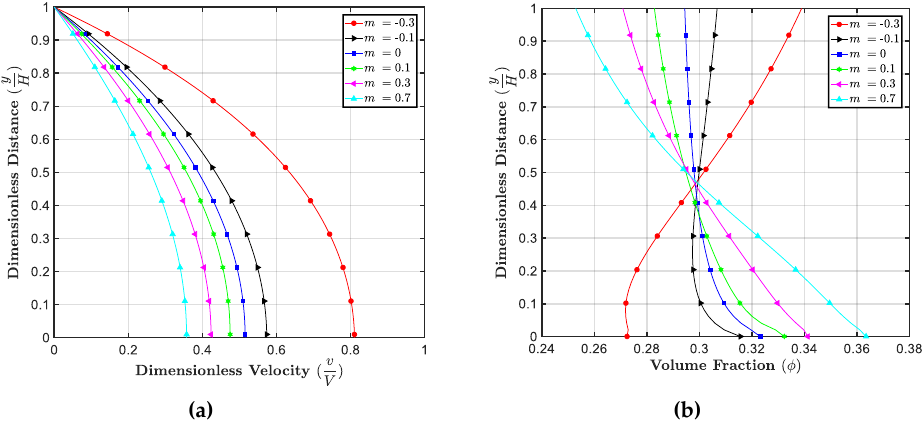
Figure 9. Effect of m on ( a ) the velocity; and ( b ) the volume fraction profiles, with 𝛽 = 1.82, 𝜙 𝑎𝑣𝑔 = Figure 9. E ff ect of m on ( a ) the velocity; and ( b ) the volume fraction profiles, with β = 1.82, = 0.05, 𝜙 𝑚 = 0.65, 𝜃 = 90°. 0.3, 𝑅 0 = 0.1, 𝑅 1 = − 2.5, 𝑅 2 = 10, 𝑅 3 = 0.01, 𝑅 4 = 0.07, 𝑅 5 = 1.8, 𝐾 𝑐 φ − 2.5, R = 10, R = 0.01, R = 0.07, R = 1.8, K c = 0.05, φ m = 0.65, θ = 90 ◦ . 𝐾 𝜇 avg = 0.3, R 0 = 0.1, R 1 = 2 3 5 4 K µ